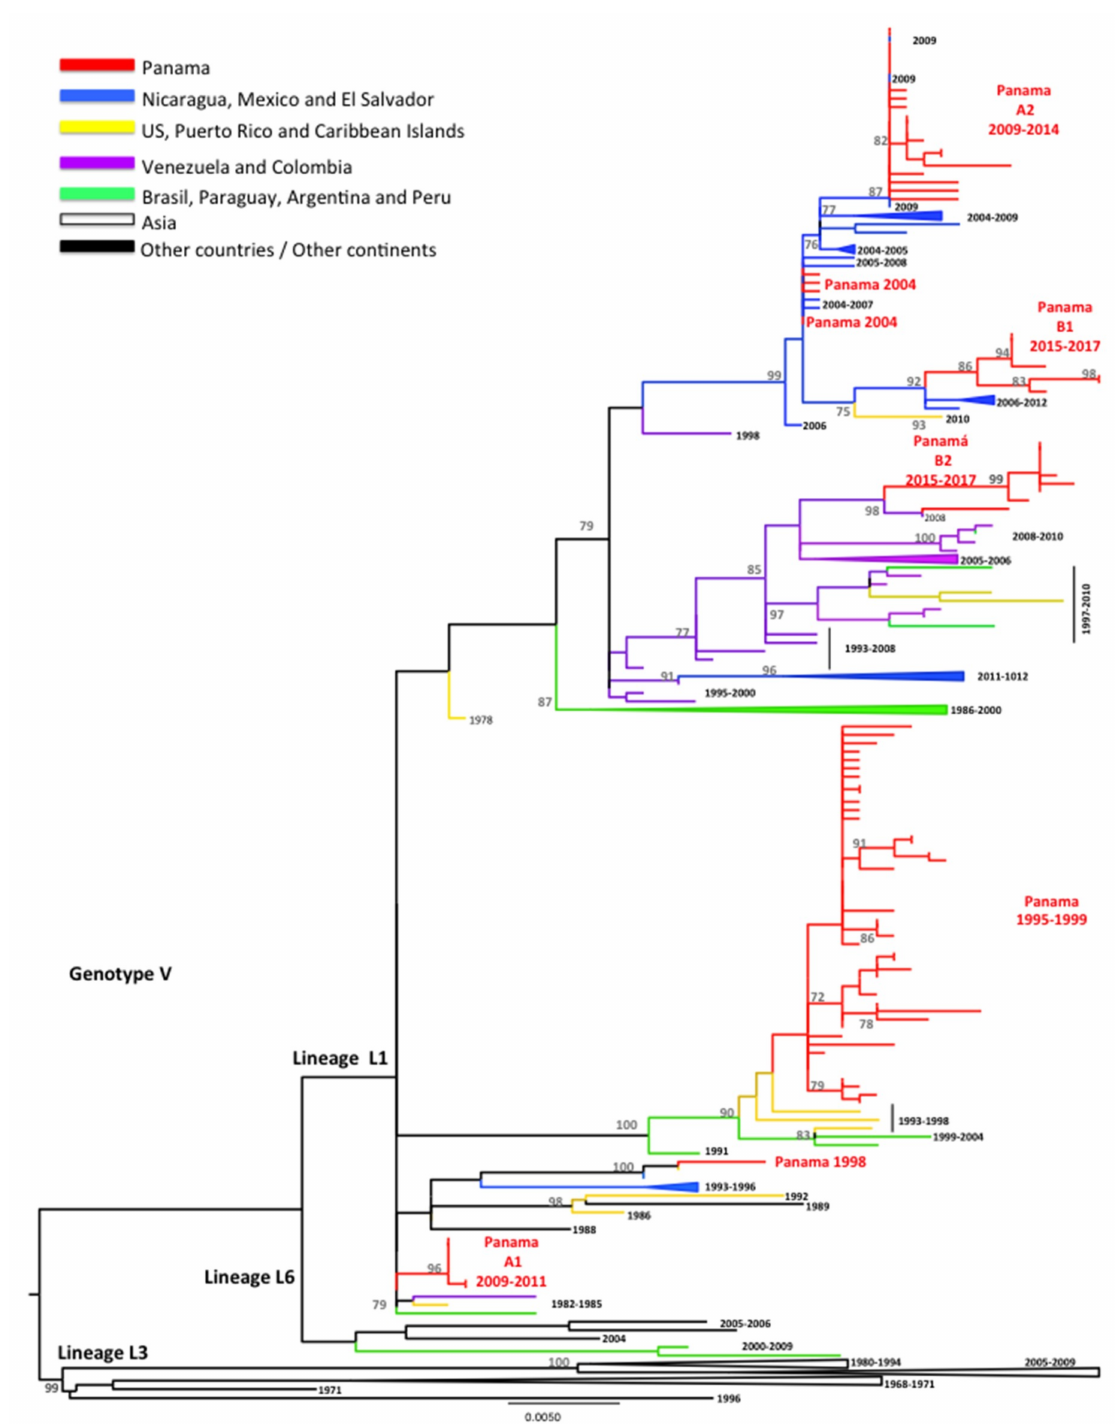
Figure 2. Maximum Likelihood tree (ML) of DENV-1 envelope (E) protein genes. The ML tree was constructed using the model General Time Reversible (GTR + I + gamma), with bootstrap values > 70 (1000 replicates). Red color represents DENV-1 Panamanian strains ( n =